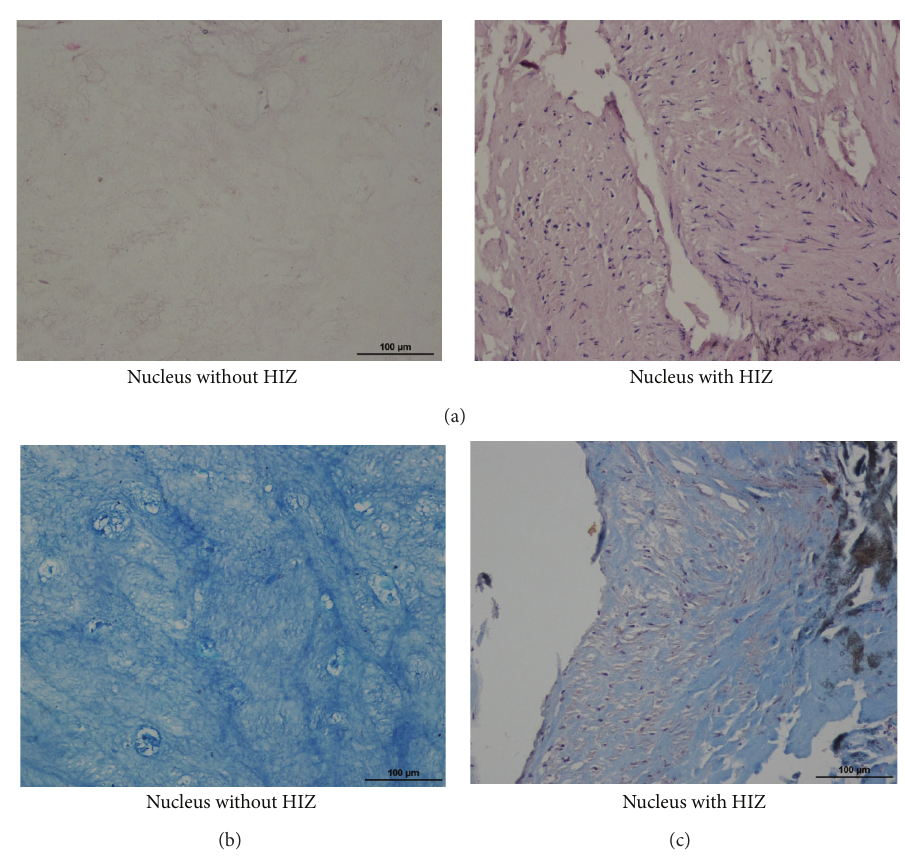
Figure 6: Histological findings of two kinds of tissue: the displaced nucleus pulposus (NP) with (right panel) and without (left panel) an HIZ. (a) Hematoxylin and eosin staining showing the NP without an HIZ filled with cartilaginous tissue. (b) Alcian blue staining showing the NP without an HIZ consisting of extracellular matrix of proteoglycan-based cartilage. (c) Masson trichrome staining showing the NP with the HIZ containing many fibroblastic cells, not chondrocytes, as well as a fibrotic